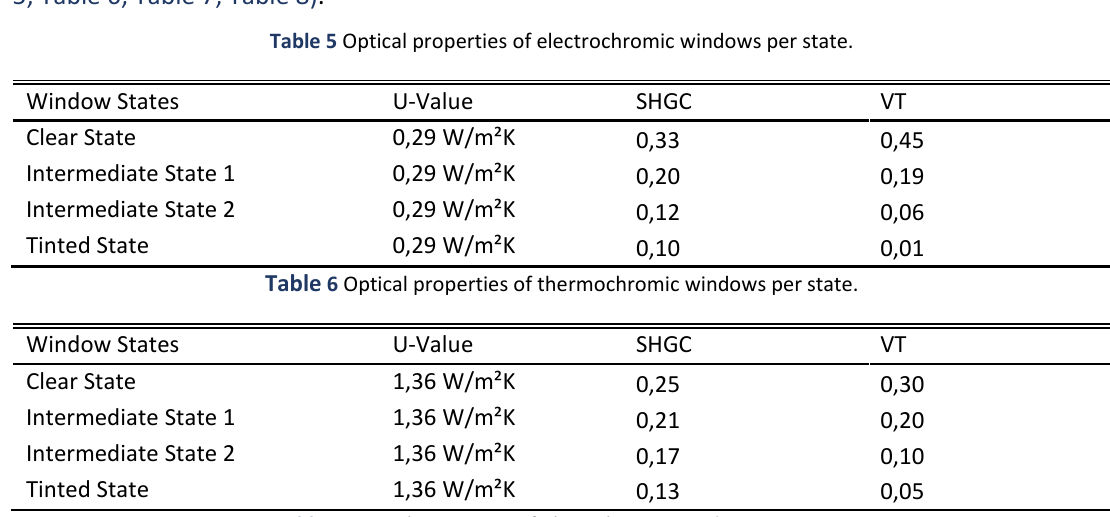
Table 7 Optical properties of photochromic windows per state.